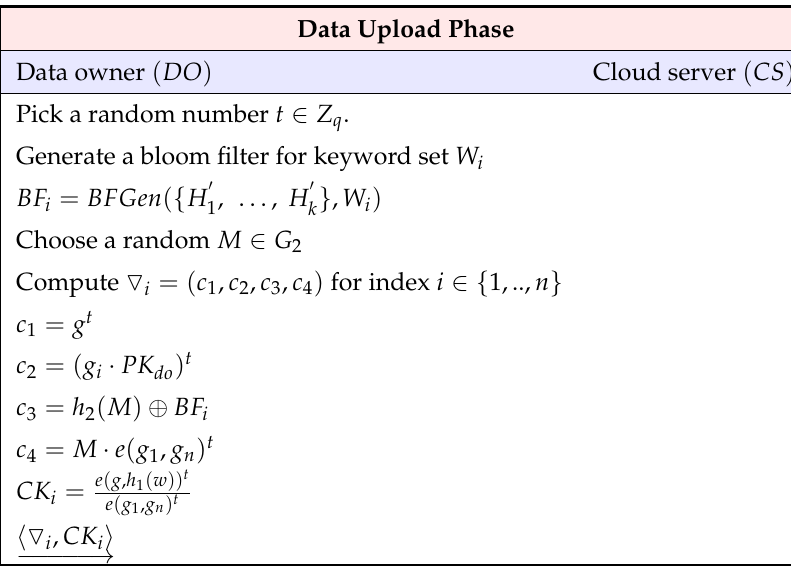
Figure 3. Data upload